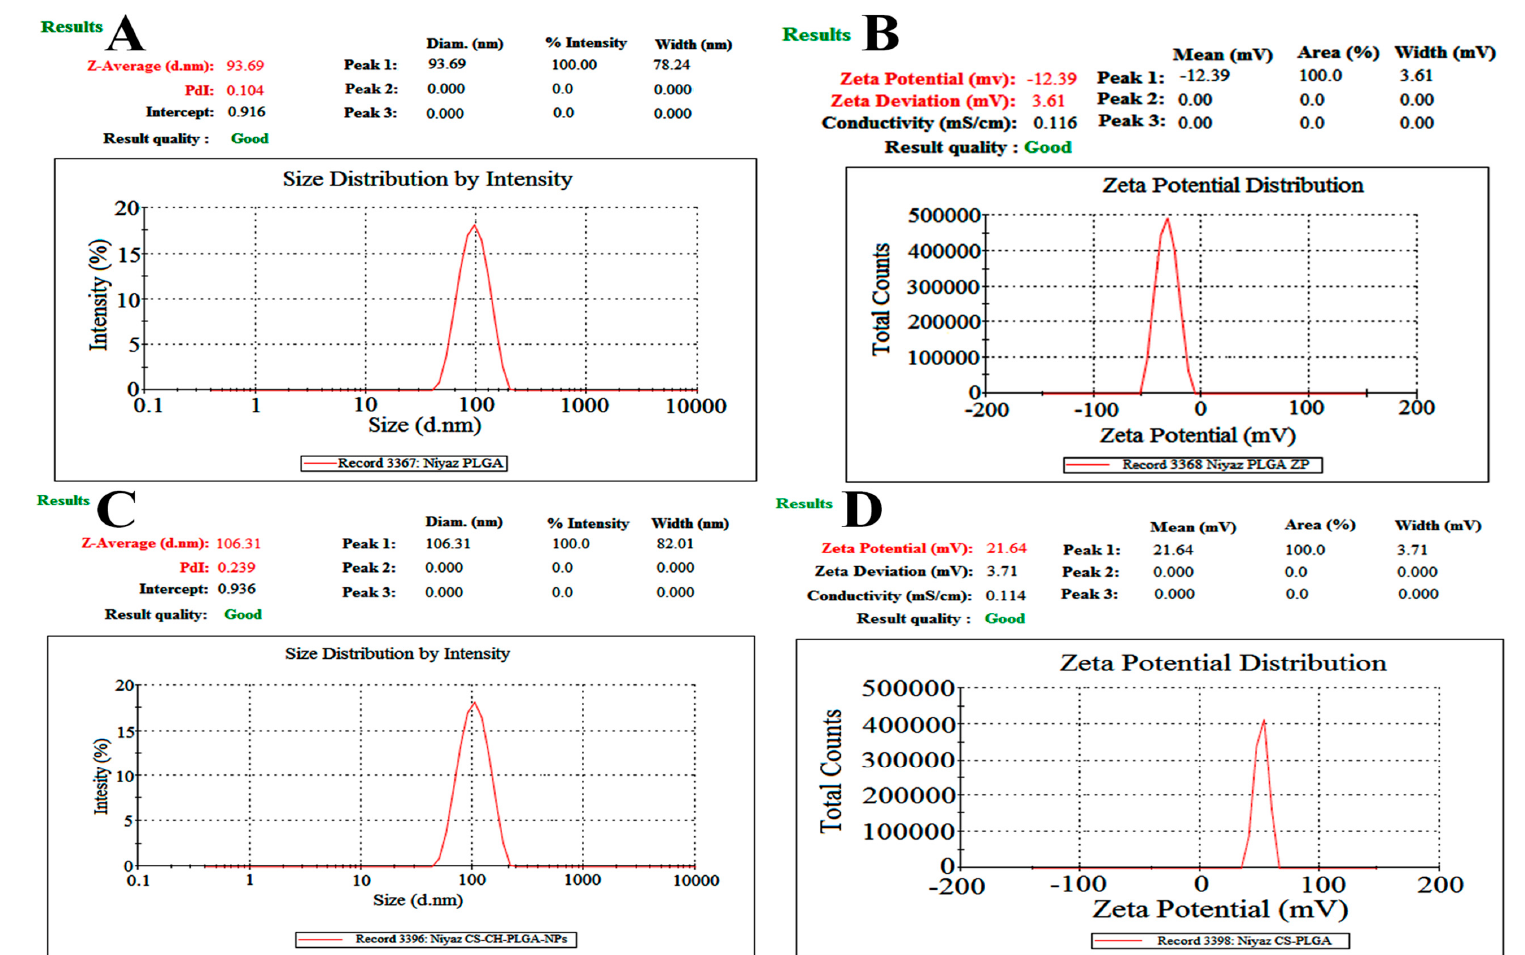
Figure 4. Dynamic light scattering techniques for determining the particle size distribution of CH-loaded–PLGA–NPs’ globule size ( A ) and Zeta potential ( B ), as well as CS-coated–CH-loaded–PLGA–NPs’ particle size ( C ) and zeta potential ( D ) images.